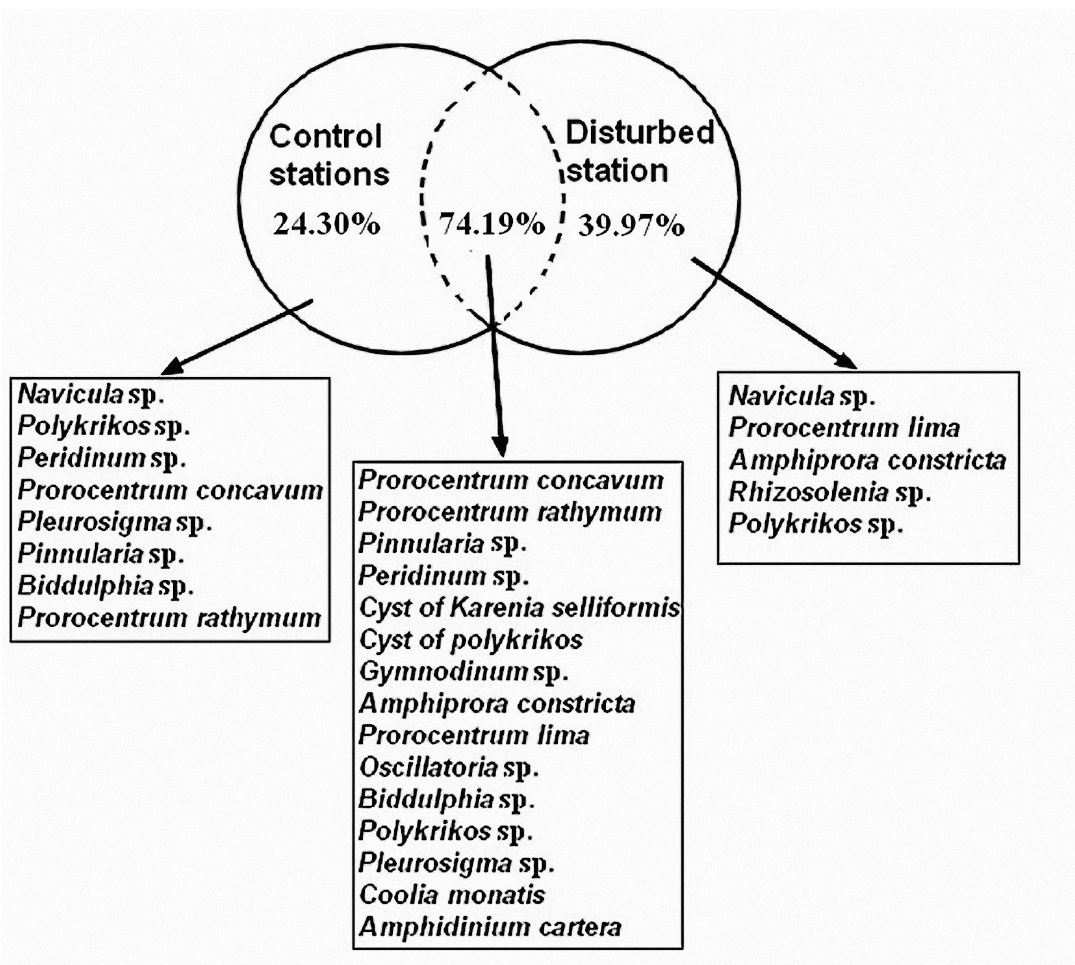
Fig. 4. – Diagram showing the average similarity within each sampling station (continuous line and percentages), the average dissimilarity between control and disturbed station (broken line and percentages), and the distribution of discriminating species following SIMPER